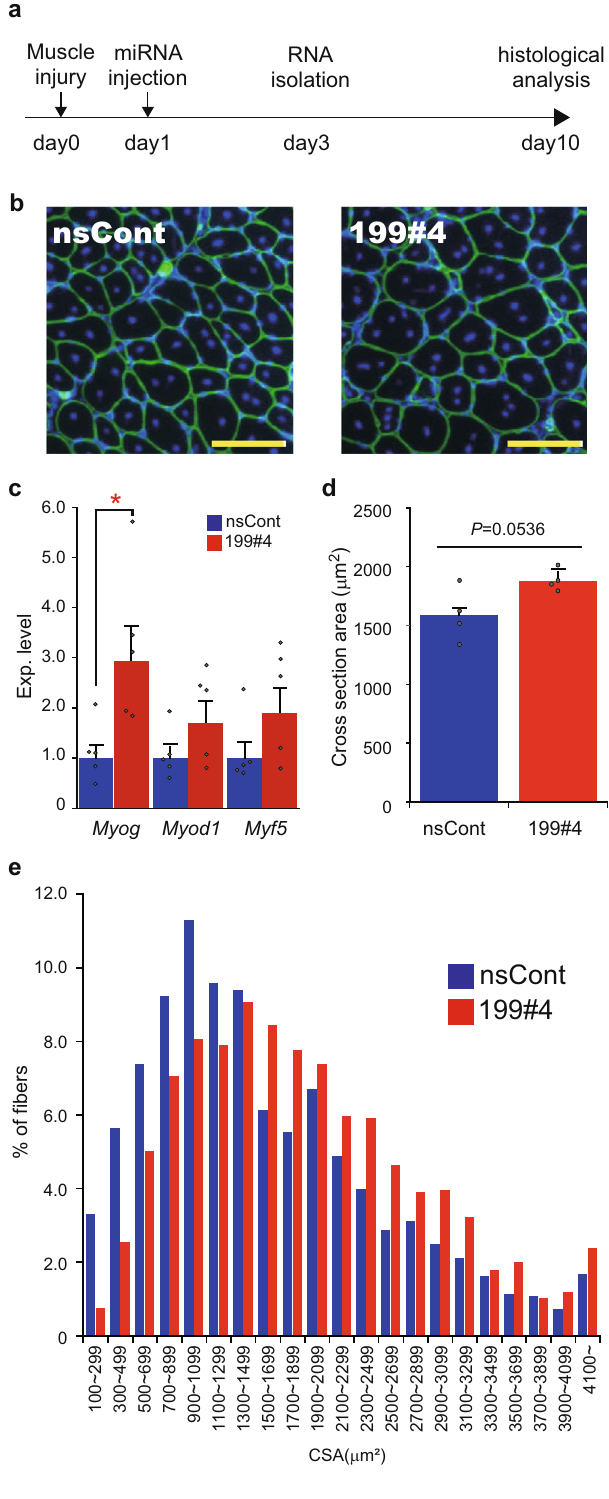
examined. Age-related muscle weakness in miR199#4-treated mice was signi fi cantly suppressed compared to that in control mice treated with nsCont (Fig. 7).